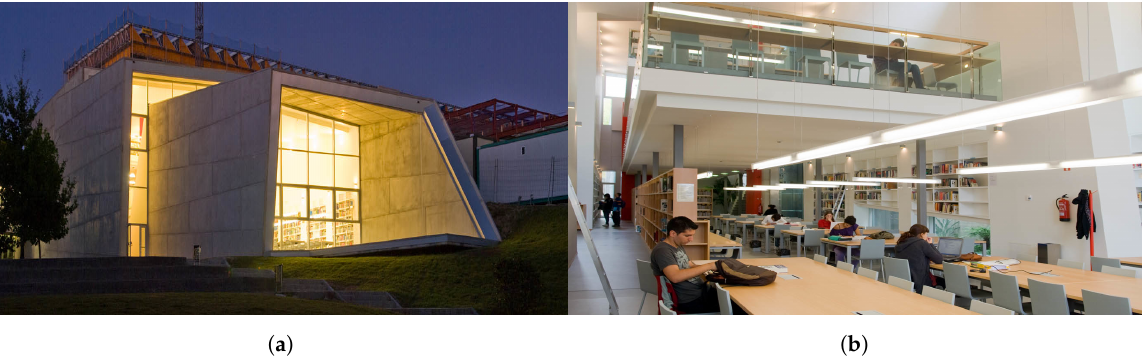
Figure 1. Appearance of the analysed building: ( a ) exterior and ( b )